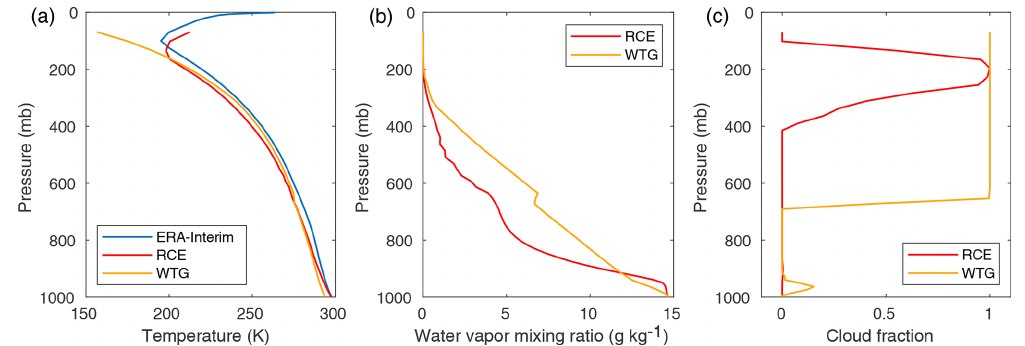
Figure 1. (a) Tropical soundings from ERA-Interim reanalysis (observational) data and averages over the last 30d of two 180d WRF SCM experiments: one an RCE experiment and one with the WTG approximation active, both with fixed 300K SST. (b) Water vapor mixing ratio profiles from the same RCE and WTG experiments. (c) Cloud fraction profiles from the same RCE and WTG experiments.